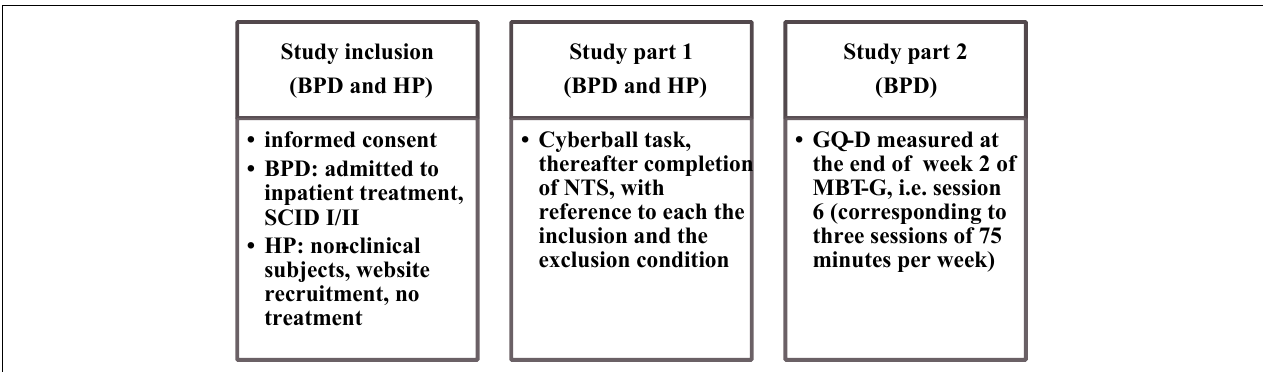
FIGURE 1 | Study design. BPD = Borderline Personality Disorder, HP = healthy participants; SCID = Structured Clinical Interview for DSM Disorders (SCID I and II; Wittchen et al., 1997); NTS = Need Threat Scale (Jamieson et al., 2010); GQ-D = Group Questionnaire, German version (Bormann et al., 2011), MBT-G = Mentalization-based group psychotherapy (Karterud,